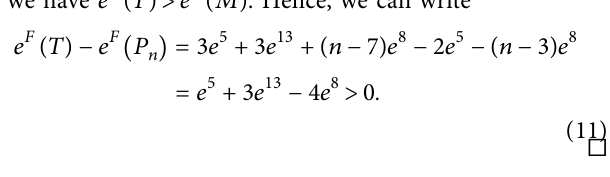
Figure 5: The trees T and T